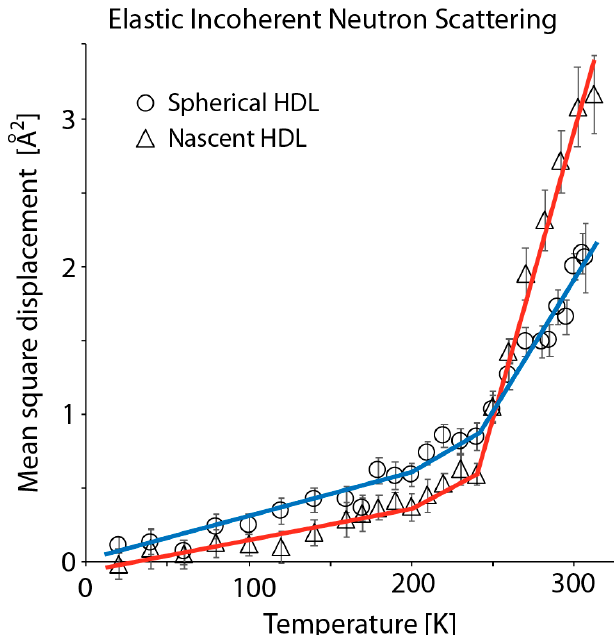
Figure 1. Mean square displacement (MSD) of atoms in reconstituted discoidal and spherical high-density lipoprotein (HDL) (hydrated powder) calculated from elastic incoherent neutron scattering (EINS) data collected on spectrometer IN13. The graph shows a comparison of MSD obtained from measurements of reconstituted spherical HDL particles (rsHDL) (open circle) and reconstituted discoidal HDL (rHDL) (open triangle) in the temperature range 20–310 K. The variation of MSD with temperature showed three linear domains that could be related with three different force constants for particle dynamics. The linear domains were marked with line segments (blue for rsHDL, and red for rHDL). The two MSD curves intersected at ~250 K. Overall, rsHDL was slightly more dynamic than rHDL for T < 250 K, but the latter became much more dynamic at ambient temperature.